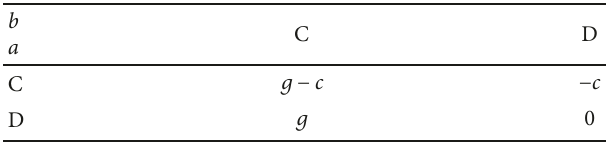
Table 1: Payo ff s for agent a against agent b in a prisoner ’ s dilemma game; g > 0 and c > 0